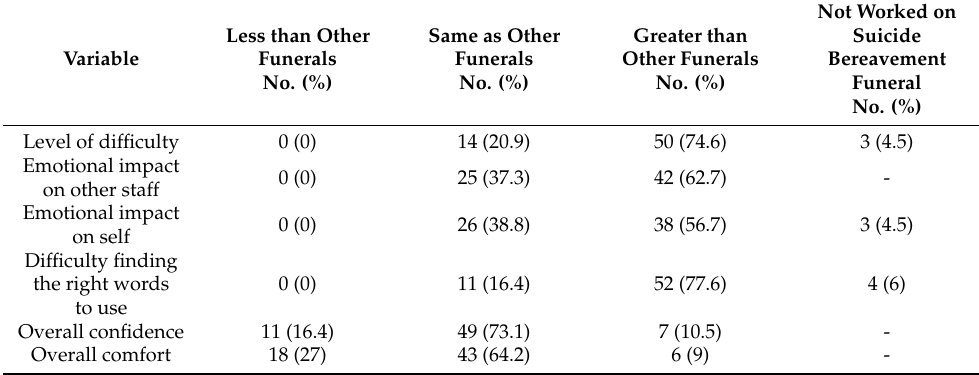
Table 1. Baseline questionnaire results ( n = 67).